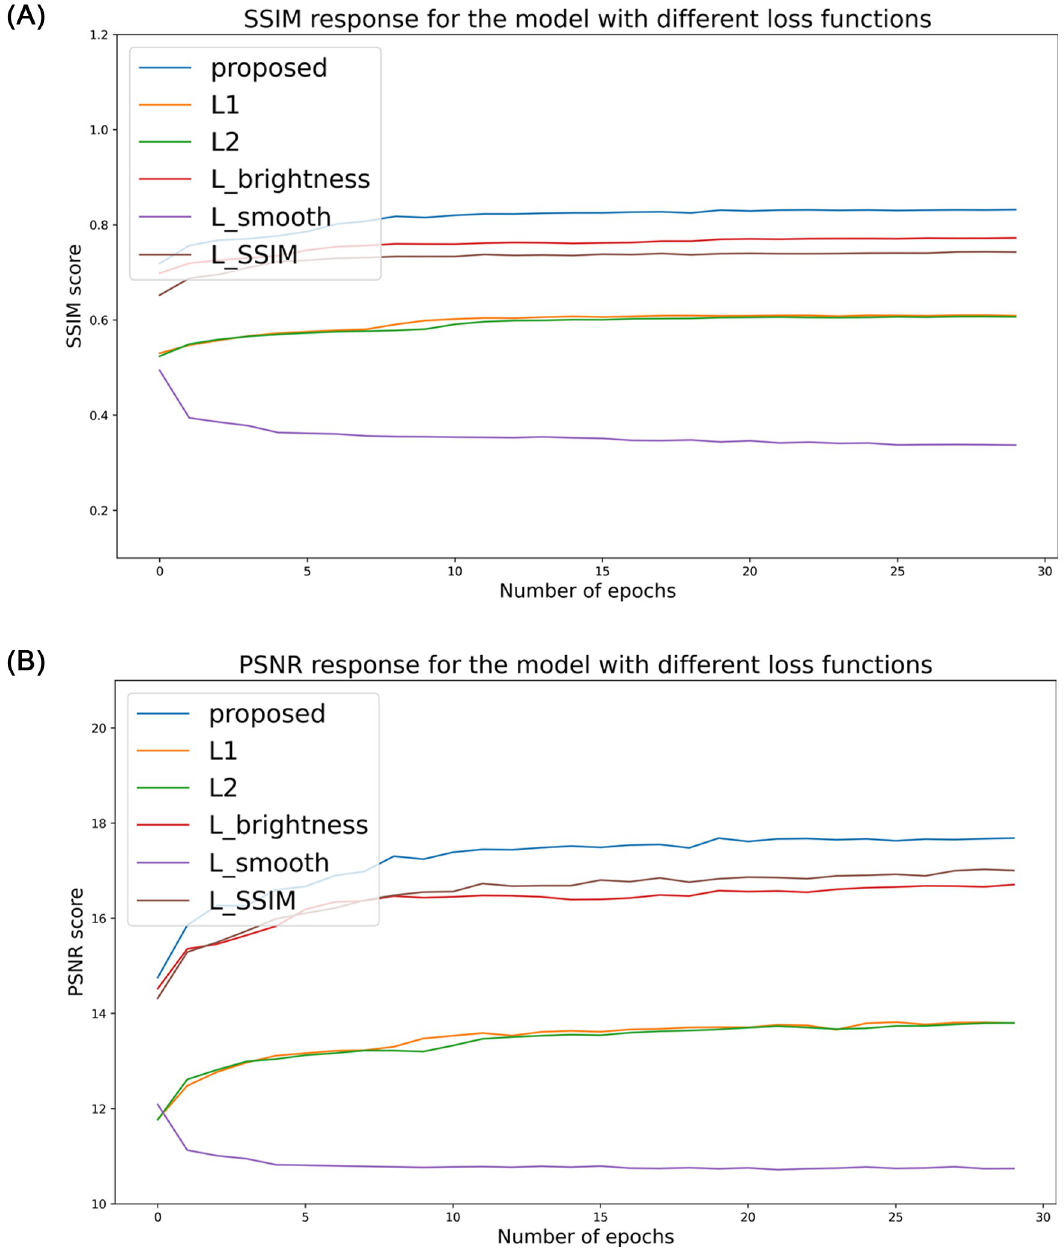
Fig 3. The response for the each loss functions used in our work. Under the same initialization, proposed combined loss-function avails better SSIM and PSNR response than the individual loss functions. (a) Epoch vs. SSIM response due to the loss functions and (b) Epoch vs. PSNR response due to the loss